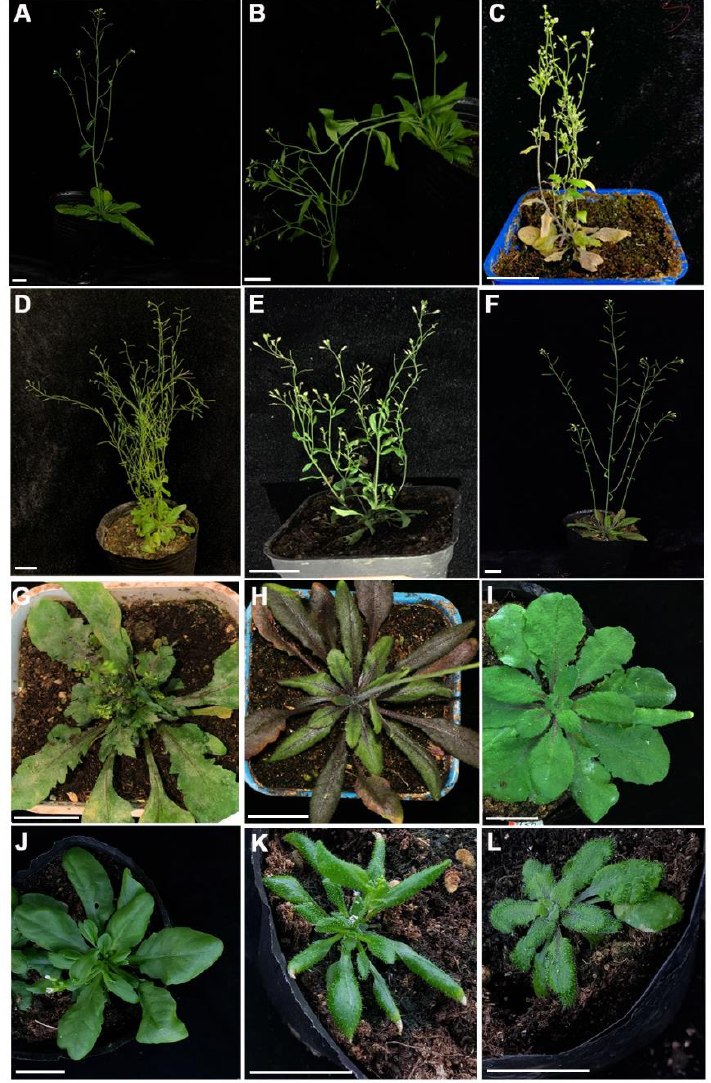
Figure 2. Morphological phenotypes of transgenic plants from the FOX library under normal conditions. ( A ) Wild-type (WT). ( B ) Lodging. ( C ) Early senescence and shorter siliques. ( D ) Smaller florescence leaves and more branches. ( E ) Poor growth and smaller siliques. ( F ) Stiffer stems. ( G ) Bigger leaves and later bolting. ( H ) Fewer branches and enhanced anthocyanin accumulation. ( I ) Thick leaves and later bolting. ( J ) Glabrous leaves. ( K ) Curled leaves. ( L ) Wrinkled leaves. Scale bars: (A–L) 2